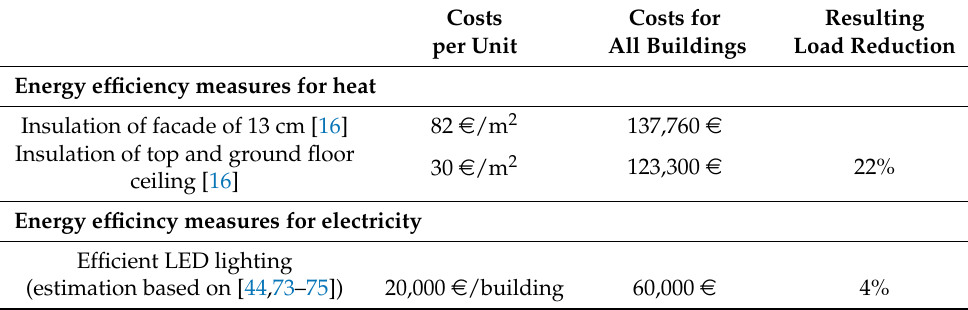
energy efficiency measures’ business case. Table A1. Energy efficiency measures